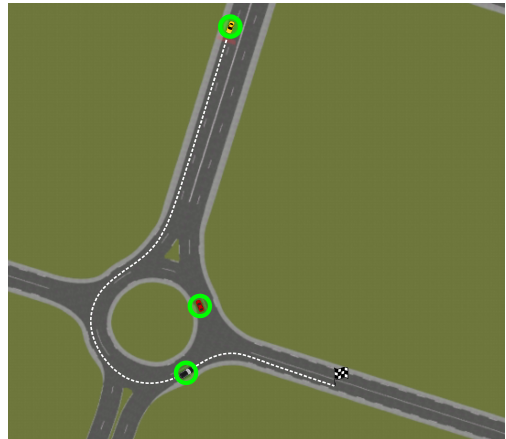
Figure 16. Experimental setup for simulation